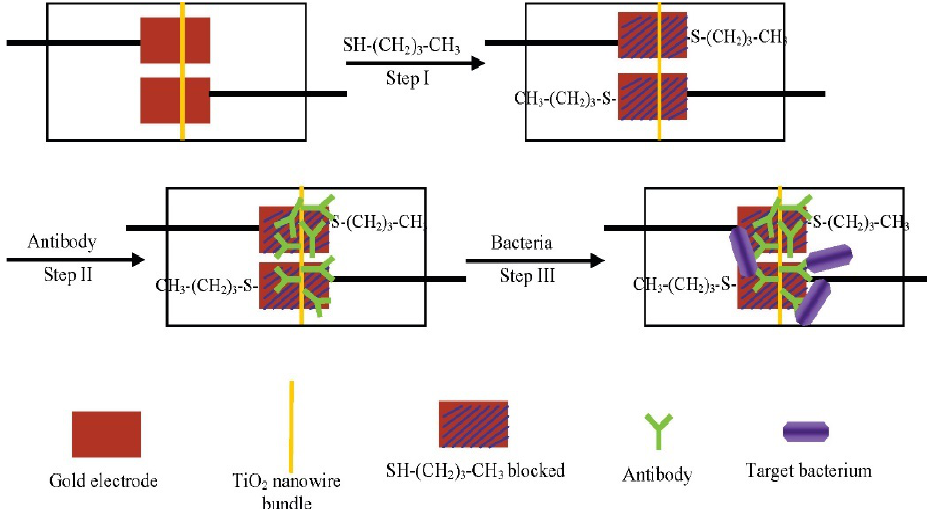
Figure 3. Principle of detection of bacteria such as L. monocytogenes using a TiO2 nanowire bundle microelectrode-based impedance immunosensor. Reprinted with permission from ref. [60]. Copyright 2008, American Chemical Society.